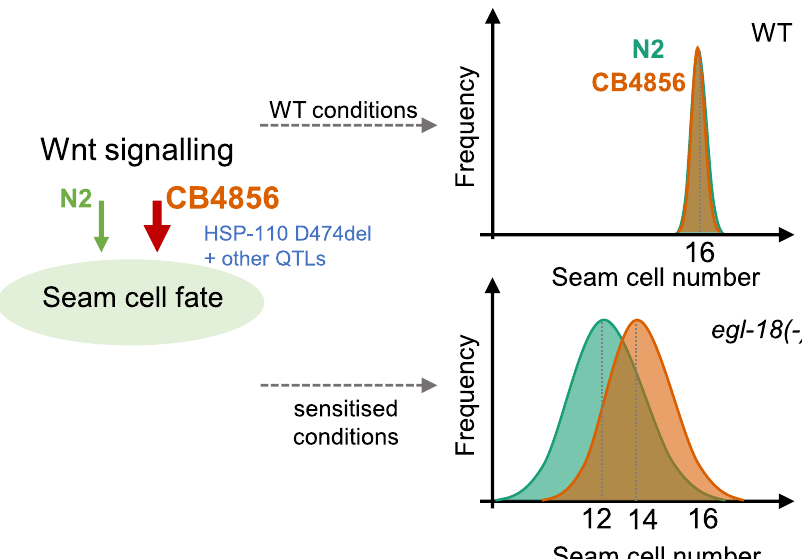
Fig. 7 Model explaining the difference in the outcome of the egl-18(ga97) mutation between N2 and CB4856. Seam cell number distribution is shifted in egl-18 mutants in CB4856 (orange) compared with N2 (green) towards a higher average. Genetic variation in hsp-110 and other loci within the identi fi ed QTL regions in CB4856 may potentiate Wnt signalling and thus reinforce seam cell fate acquisition. This effect is only revealed in sensitised conditions, such as upon egl-18 loss-of-function or pop-1